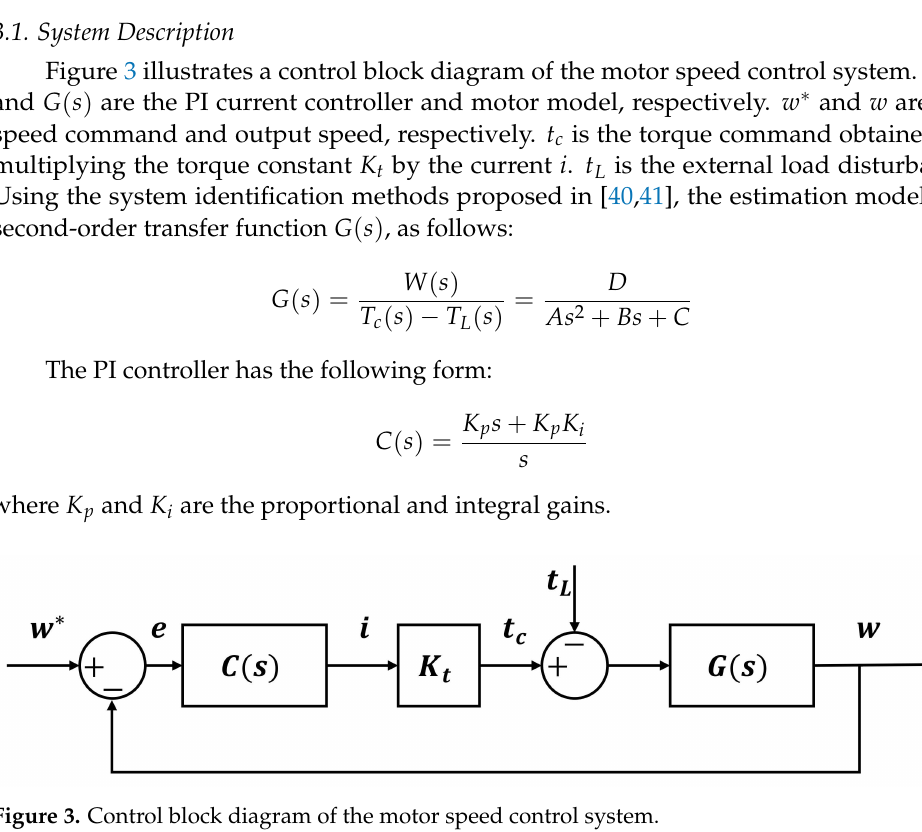
Figure 3. Control block diagram of the motor speed control